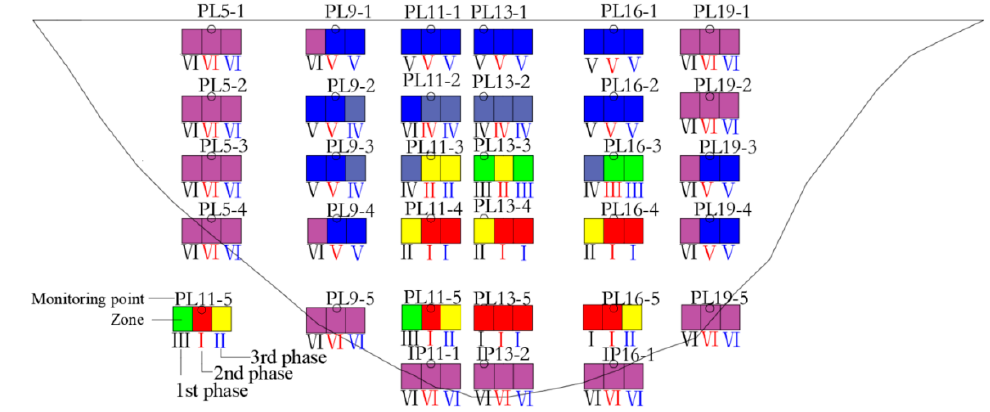
Figure 10. Deformation zoning of the ultra-high arch dam in different operation phases.